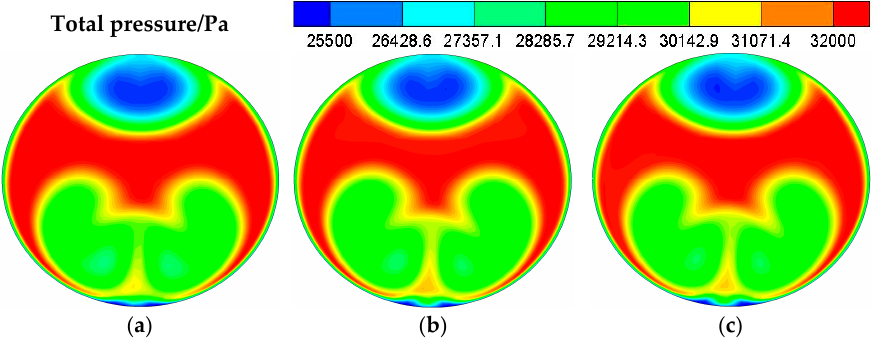
Figure 7. Total pressure distributions at outlet. ( a ) mesh-A (b) mesh-B (c) mesh-C Table 5. Total pressure statistics at outlet.